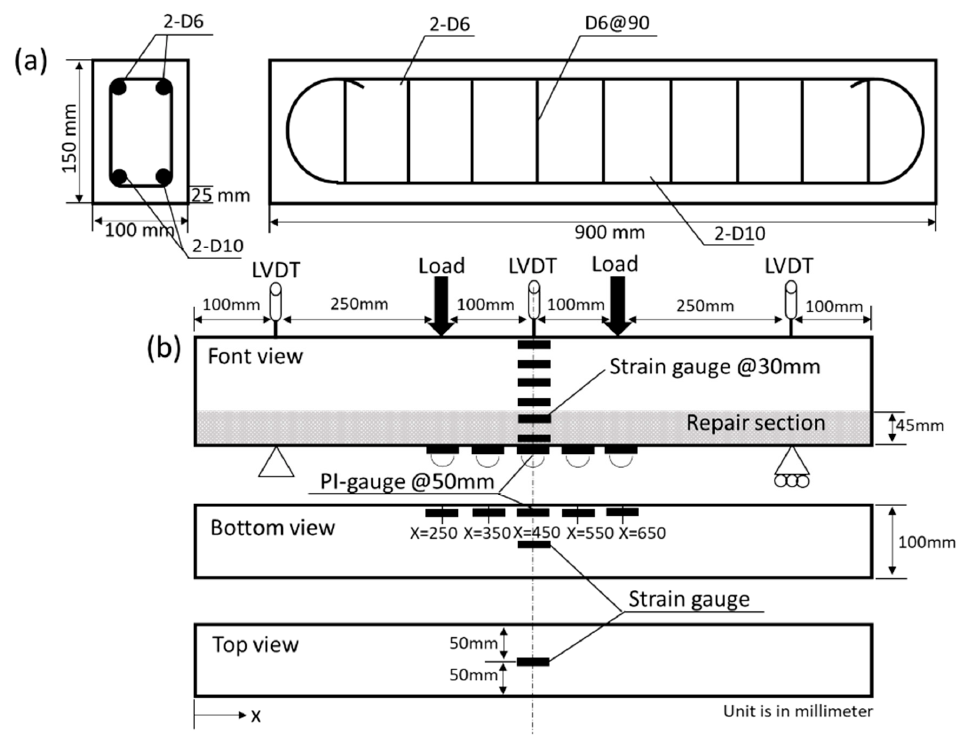
Figure 1. Tested beam: ( a ) geometry and reinforcement details; ( b ) experimental setup.